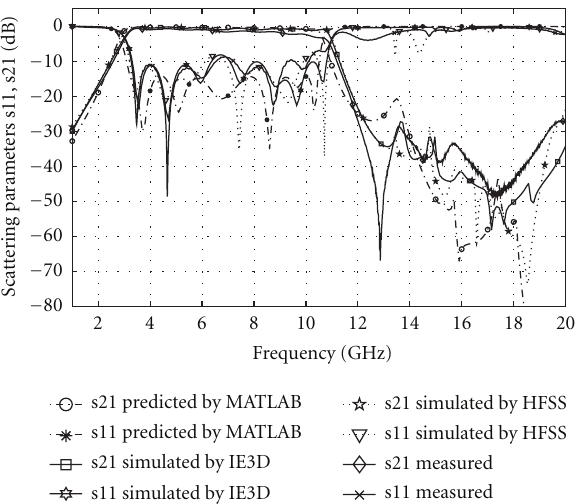
Figure 9: Comparison of the frequency response of proposed multilayered microstrip hairpin filter as obtained by the simulation softwares (IE3D and HFSS) and measurement data and those predicted by MATLAB (Example 2).